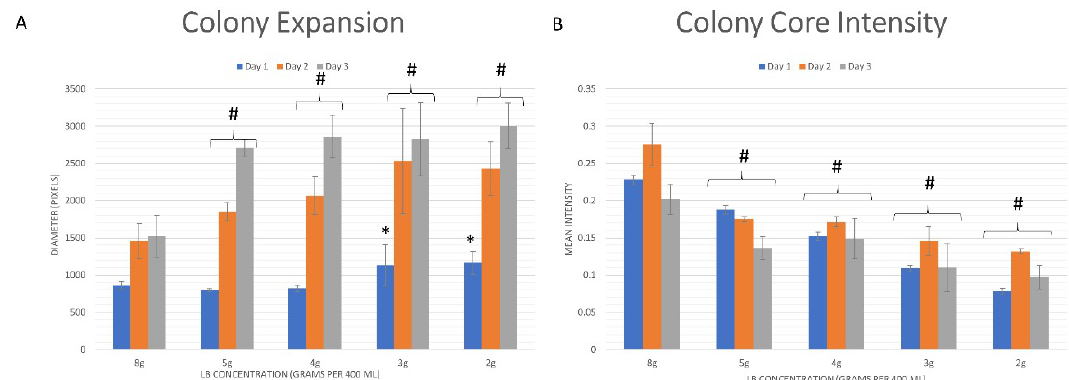
Figure 3. Whole colony expansion-intensity profiles of B. subtilis biofilms, grown to maturation over a period of 72 h. ( A ) Colony expansion; ( B ) Colony core intensity. Statistical significance is in relation with the values obtained by colonies grown on non-depleted nutrient medium (8 g LB / 400 mL), where * indicates p < 0.05, # indicates p < 0.01. The results shown are means ± standard deviations (SD) of nine independent experiments.